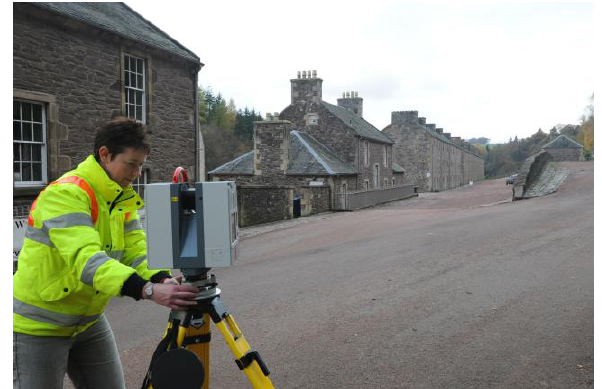
Figure 2. Terrestrial laser scanning with a phase-shift scanner at New Lanark © CDDV 2009.